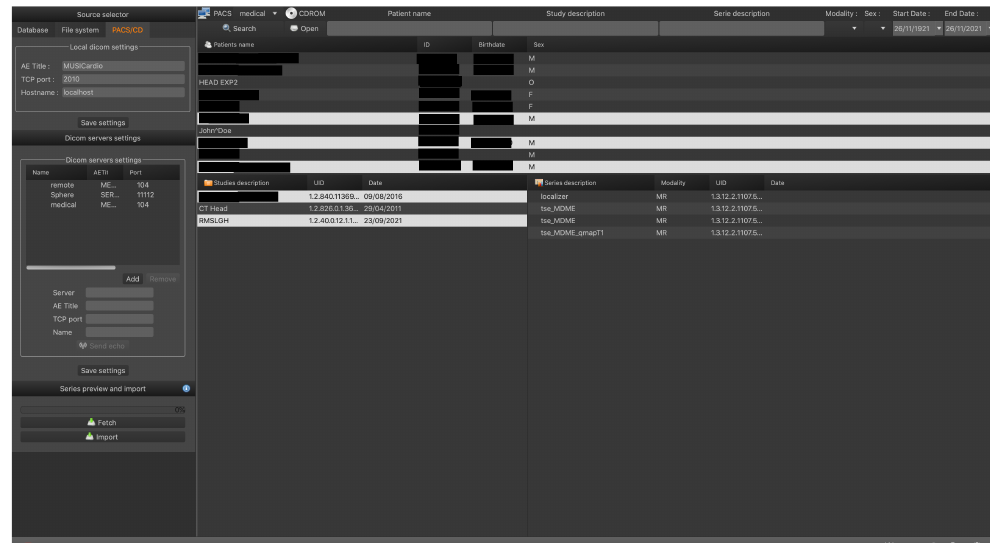
Figure 3. PACS data source.